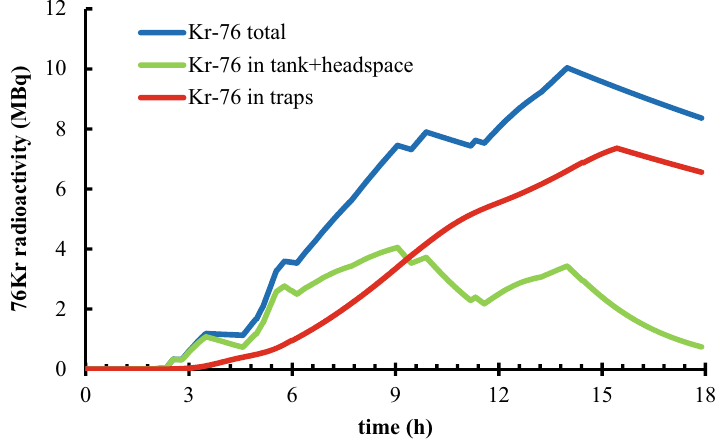
Figure 6. The predicted mass transport of 76 Kr for different locations within the harvesting system – (blue) the total 76 Kr, (green) the 76 Kr in the tank and the headspace of the tank, (red) the 76 Kr in collected on the traps.